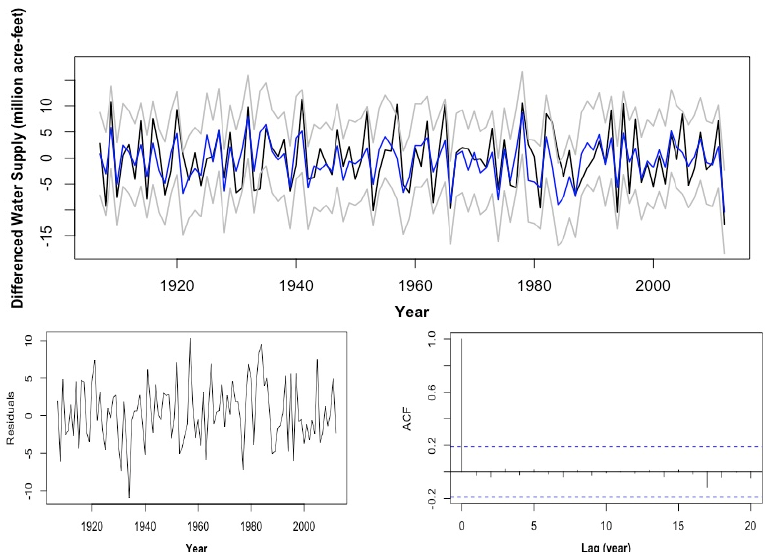
Figure 6. Diagnosis plots of the SAR (19) model: (top) overlaid plot of the observed annual water supply anomaly X t (black), model fitted value (blue) and its 95% confidence interval (grey); ( left ) residual plot; anomaly (cid:1850) (cid:3047) (black), model fitted value (blue) and its 95% confidence interval (grey); (left) residual plot; ( right ) ACF of the (right) ACF of the residual.